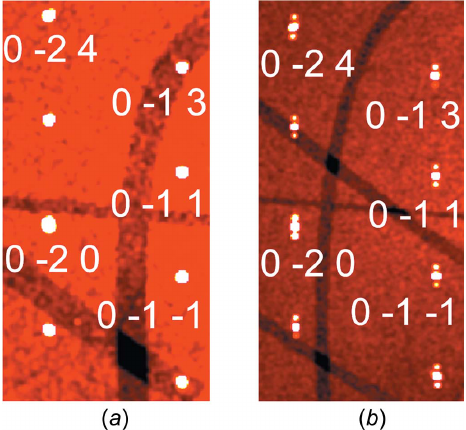
Figure 2 Excerpt of the reconstructed reciprocal layer (0, k , l ) for SXRD data measured at ( a ) T = 250 K and ( b ) T = 70 K. Indices are given for several main reflections. Panel ( b ) is better resolved than panel ( a ) because of the longer crystal-to-detector distance at 70 K. Dark bands are due to insensitive pixels between the active modules of the PILATUS3 X CdTe 1M